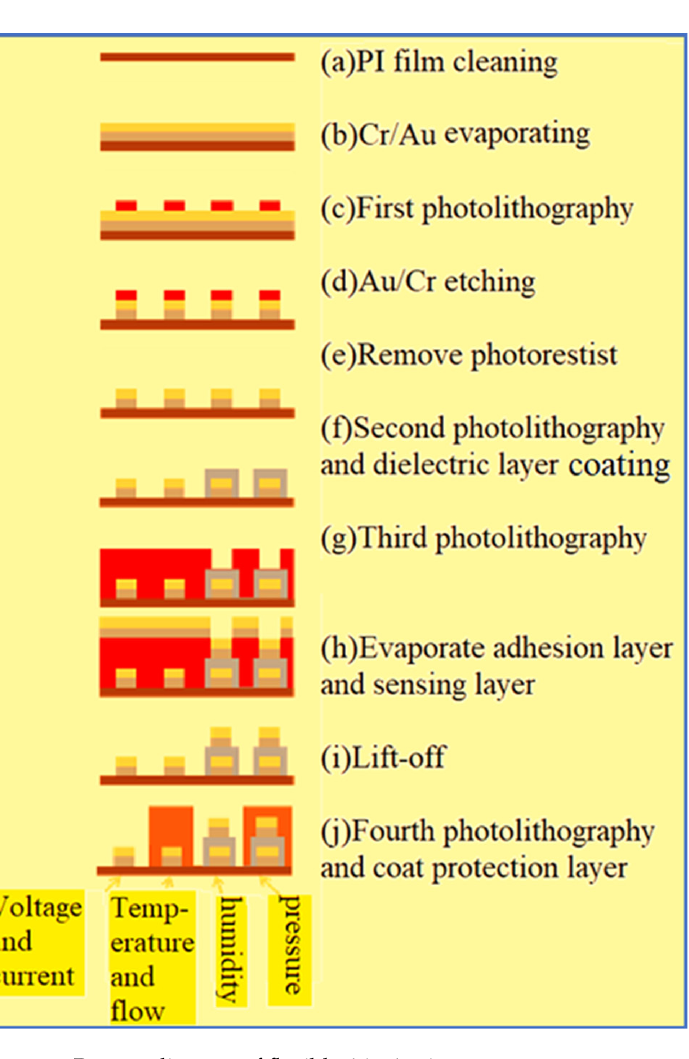
Figure 7. Process diagram of flexible 6-in-1 microsensor.